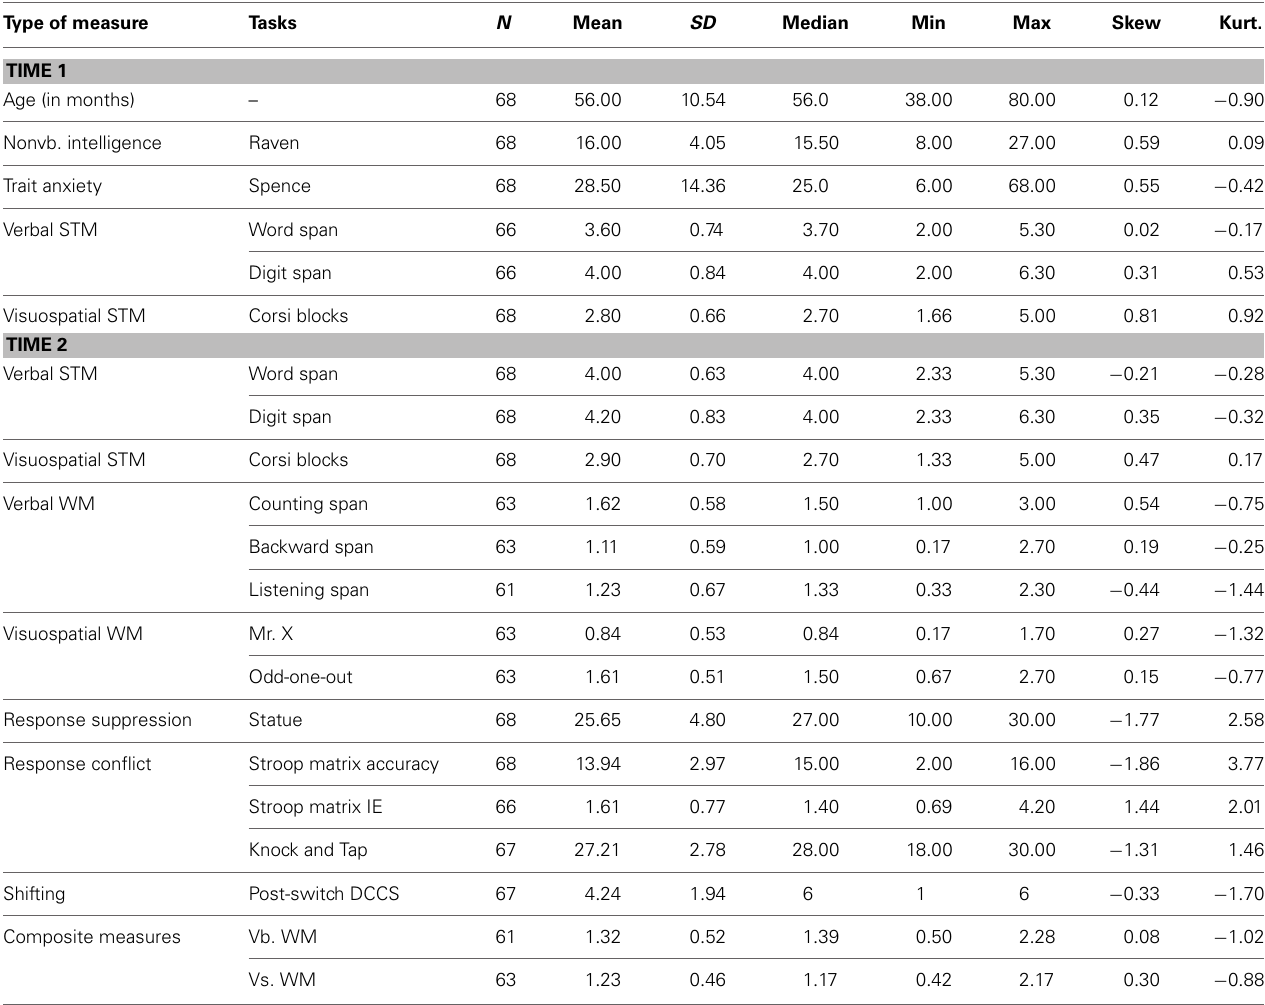
Table 1 | Univariate descriptives for the raw and composite